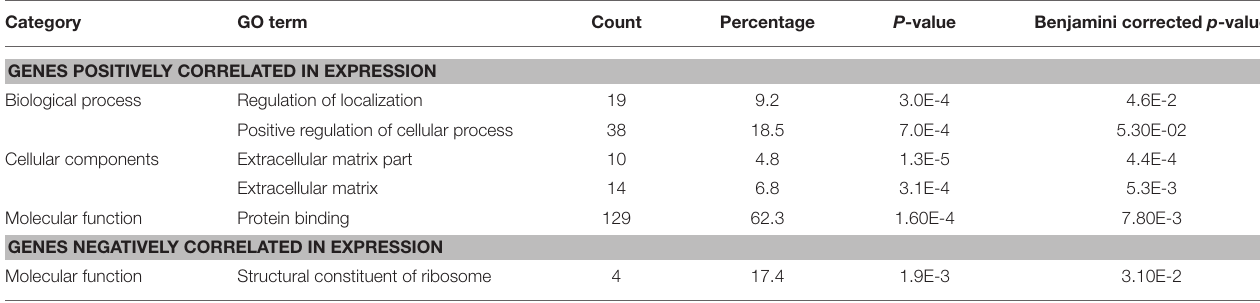
TABLE 4 | DAVID’s GO terms for protein coding transcripts positively and negatively correlated with the lncRNA MEG9. Category GO term Count Percentage P -value Benjamini corrected p